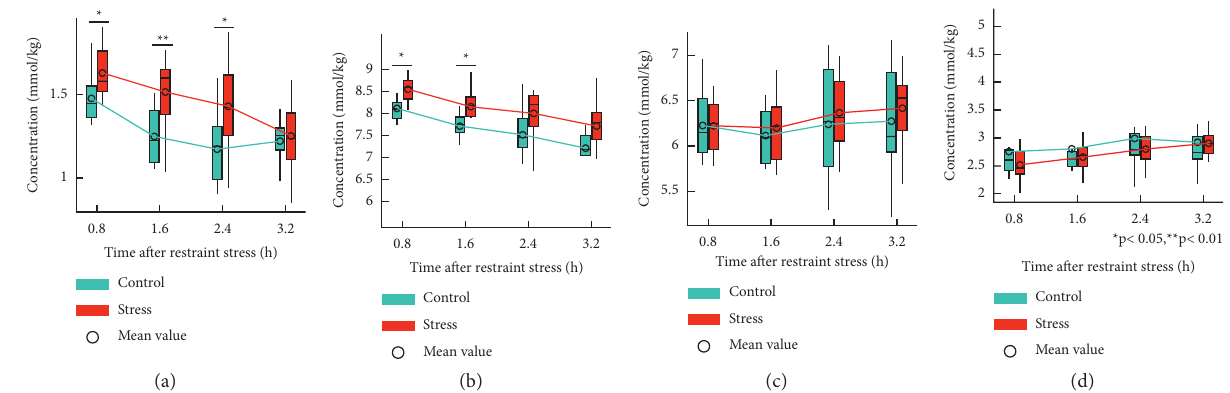
Figure 3: Student’s t -test at each time point for four metabolites related to acute restraint stress. (a) Ala, (b) Glu, (c) NAA, and (d) Gln. Each of the metabolites was represented by the change of concentration with time after acute stress. The P value that was less than or equal to the significance level was considered statistically significant.